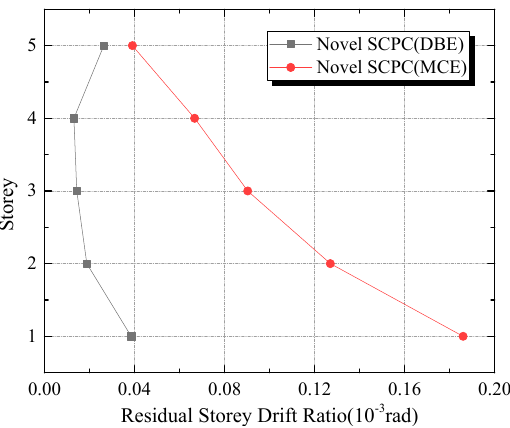
Figure 15. Maximum residual inter-story drift ratio for each story.